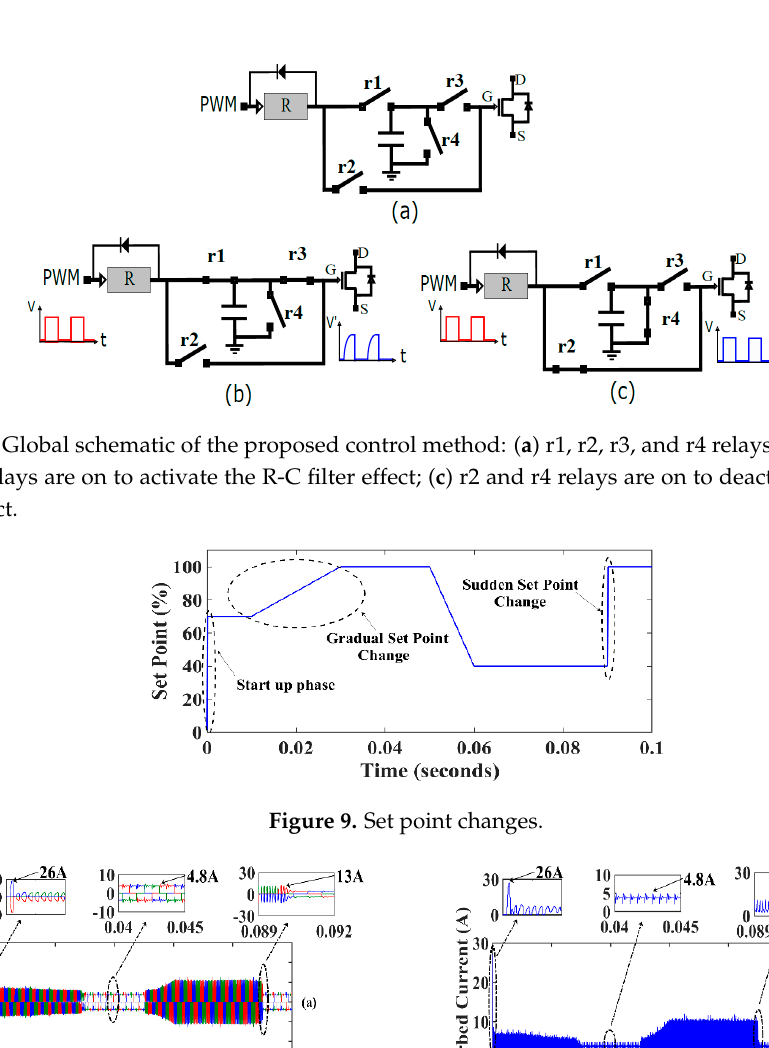
Figure 10. Current waveforms without R-C filter: ( a ) Phase currents, and ( b ) absorbed current.